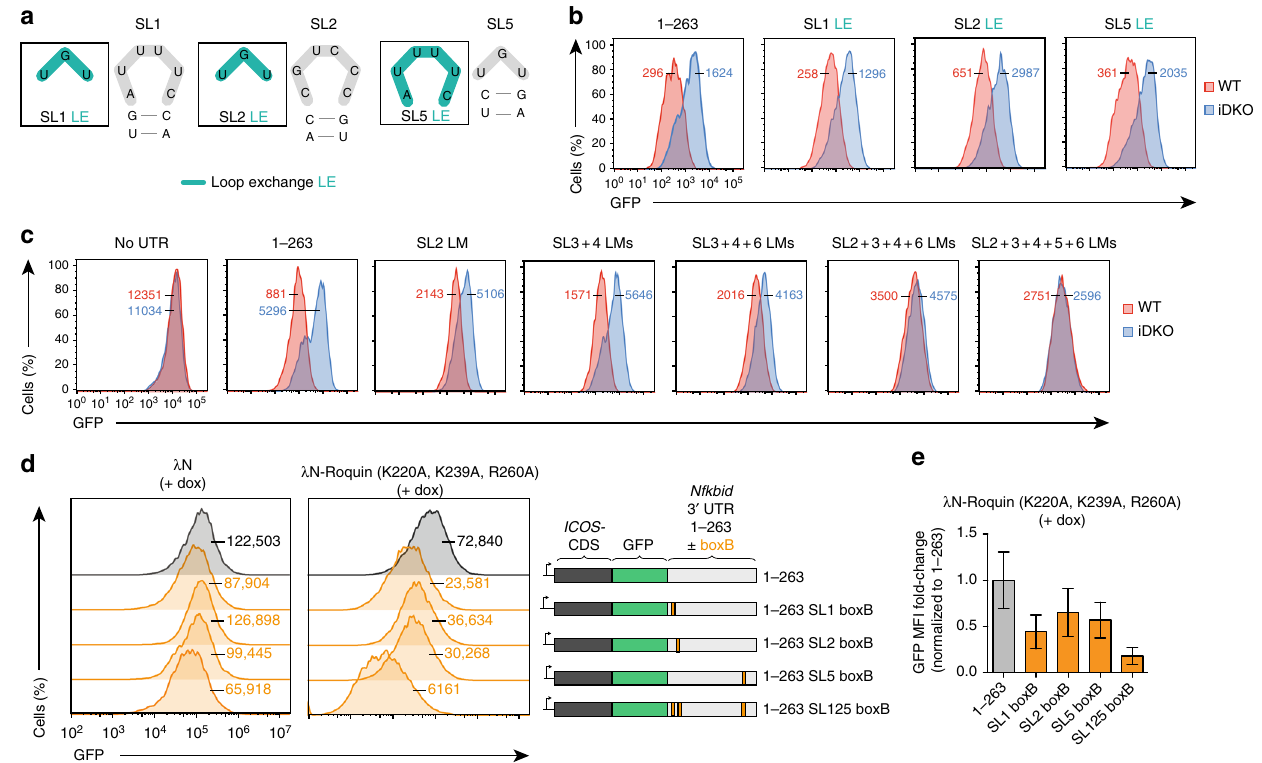
Fig. 4 Nfkbid regulation requires Roquin to interact with at least three stem – loops. a Nucleotide sequences of the loop structures of wild-type mouse Nfkbid 3 ′ -UTR stem – loops (SL) 1, 2, and 5 (gray) and introduced loop exchange mutations (LE: change of hexa- to tri-loops and vice versa, blue) are depicted. b , c Flow cytometry analysis of GFP in Rc3h1 – 2 fl / fl ; Cre-ERT2 MEF cells retrovirally transduced with the ICOS – GFP - Nfkbid 3 ′ -UTR (1 – 263) reporter containing LE mutations ( b ) and individual or combined loop mutations ( c ) in the indicated stem – loops as described in Fig. 3b. MEF cells were either treated with 4 ′ OH- tamoxifen (iDKO) or left untreated (WT). MFI of GFP is shown for WT (red) and iDKO (blue) MEF cells. ( d ) Flow cytometry analysis of GFP in the λ